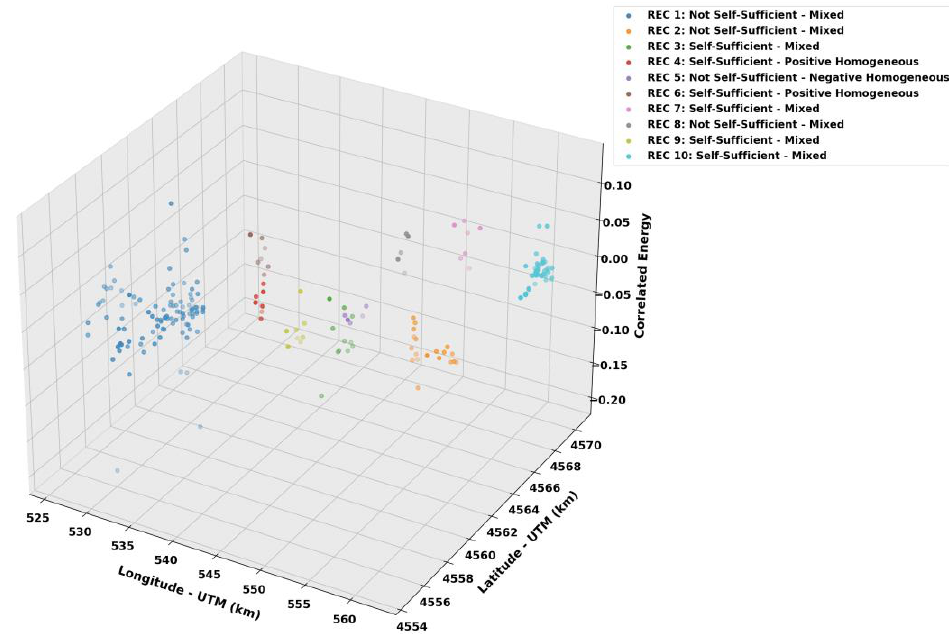
Figure 10. Members distributed by REC—DBSCAN.